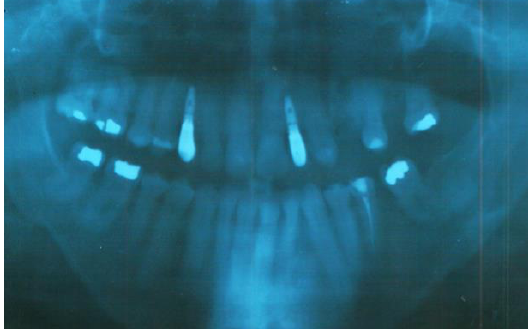
Figure 7. Final Figure 7. Final orthopantomography. Figure 7. Final orthopantomography. Figure 7. Final orthopantomography.